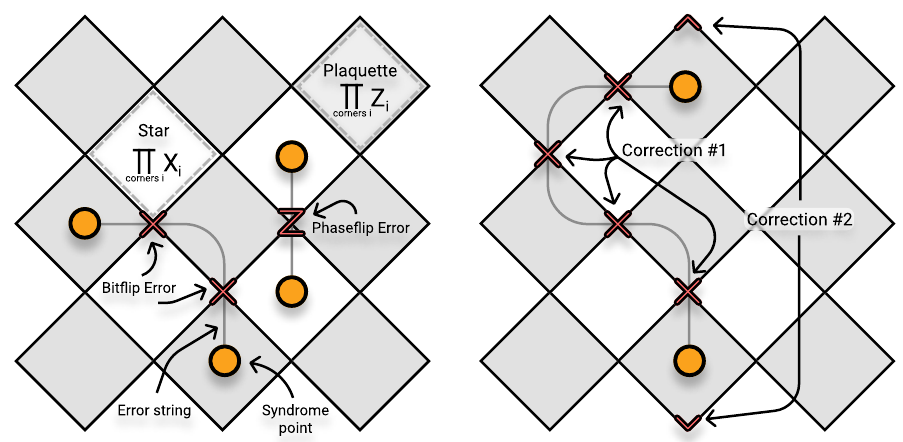
Figure 2: Left Panel : The toric code essentials. Qubits live on the vertices of the grid, with the plaquette / star operators then being formed by the (darker / lighter) squares. Bitflip errors and phaseflip errors, indicated by the X and Z operations on the vertices leave behind error strings with syndrome points at their endpoints. Right Panel : An example error string and two possible corrections that both would remove the syndrome. Correction #1 would exactly undo the errors, but correction #2 would introduce a non-trivial loop resulting in a logical